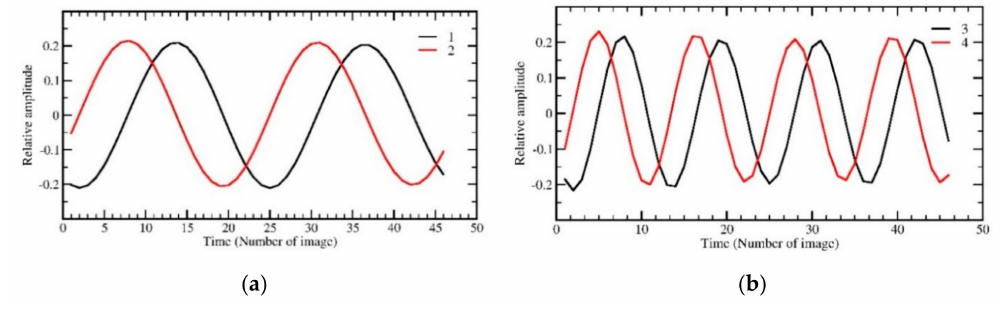
Figure 9. SSA T-EOFs of components 1–2 ( a ), and 3–4 ( b ).